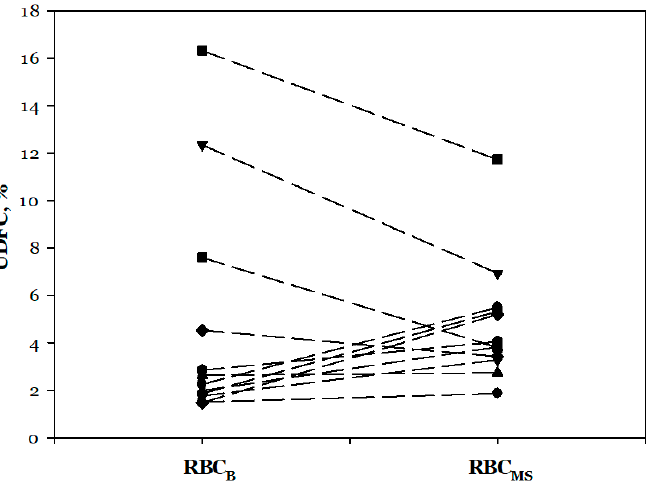
Figure 2. Percentage of undeformable cells (%UDFC) in samples collected before (RBC B ) and after mechanical stress application (RBC MS ). Mechanical stress was applied to cells by rolling freshly donated and stored RBCs with steel beads. Identical symbols designate the same RBC sample before and after applying mechanical stress. No significant difference between the two groups was observed, p =